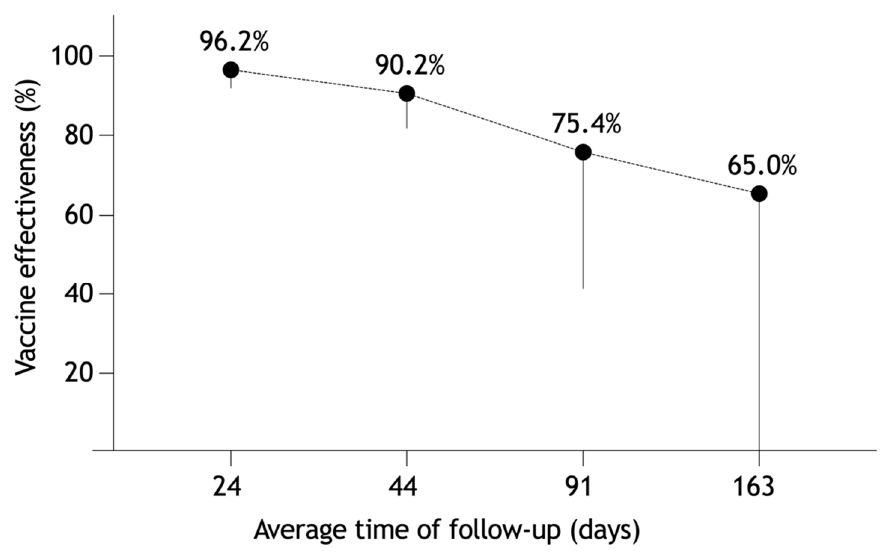
Figure 4. Persistence of vaccine effectiveness.